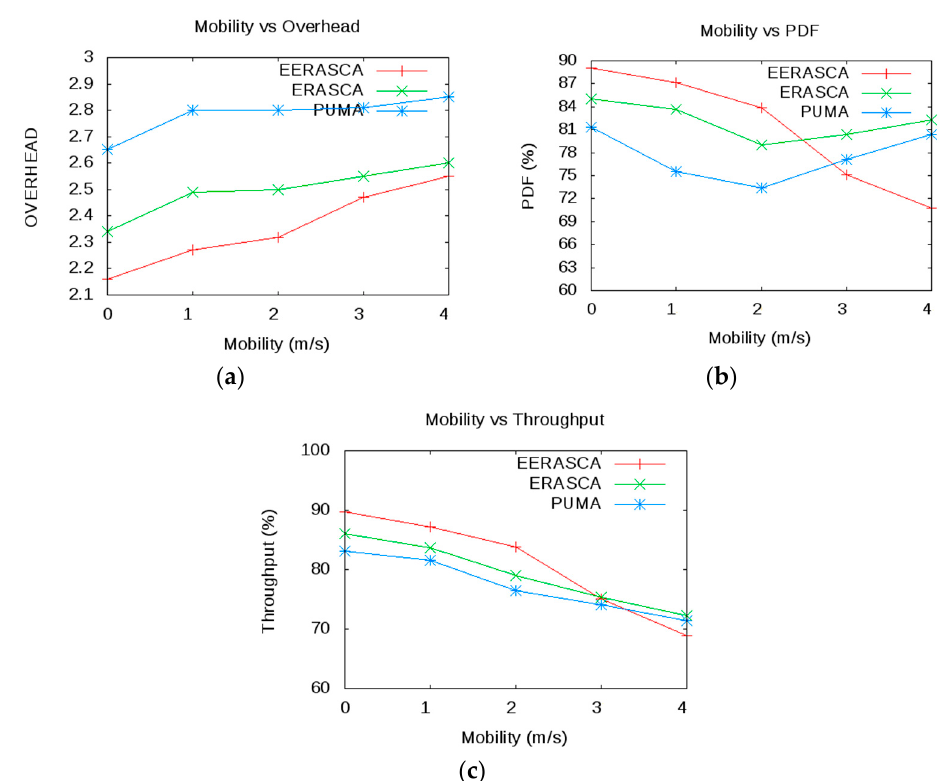
Figure 9. Comparison of Mobility with Overhead, PDF and Throughput.